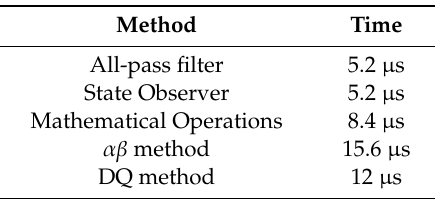
Table 6. Calculation times.